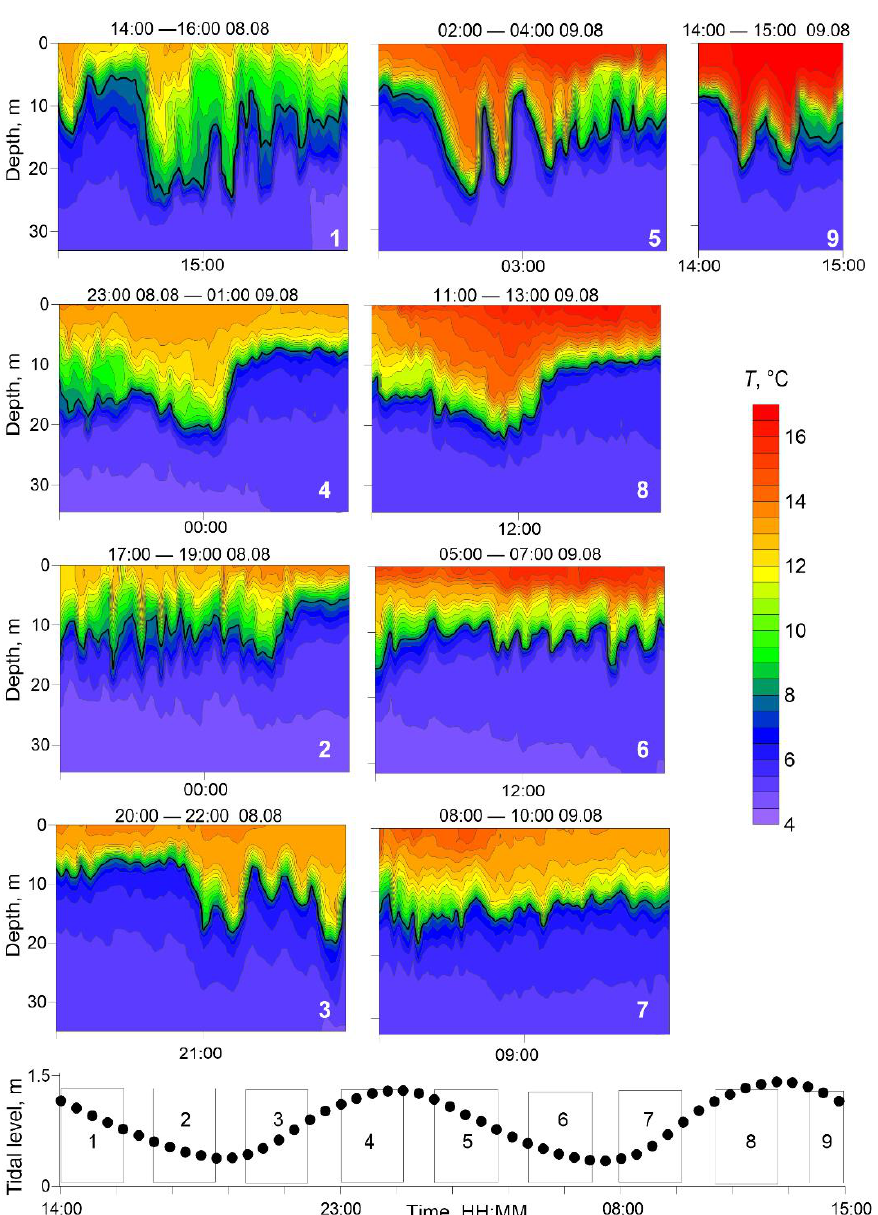
Figure 15. Vertical distribution of water temperature from repeated CTD casts made at polygon 1 during a 25 h station on 8 – 9 August 2010. Bottom graph shows tidal level variations and periods of observations marked by numbered boxes.